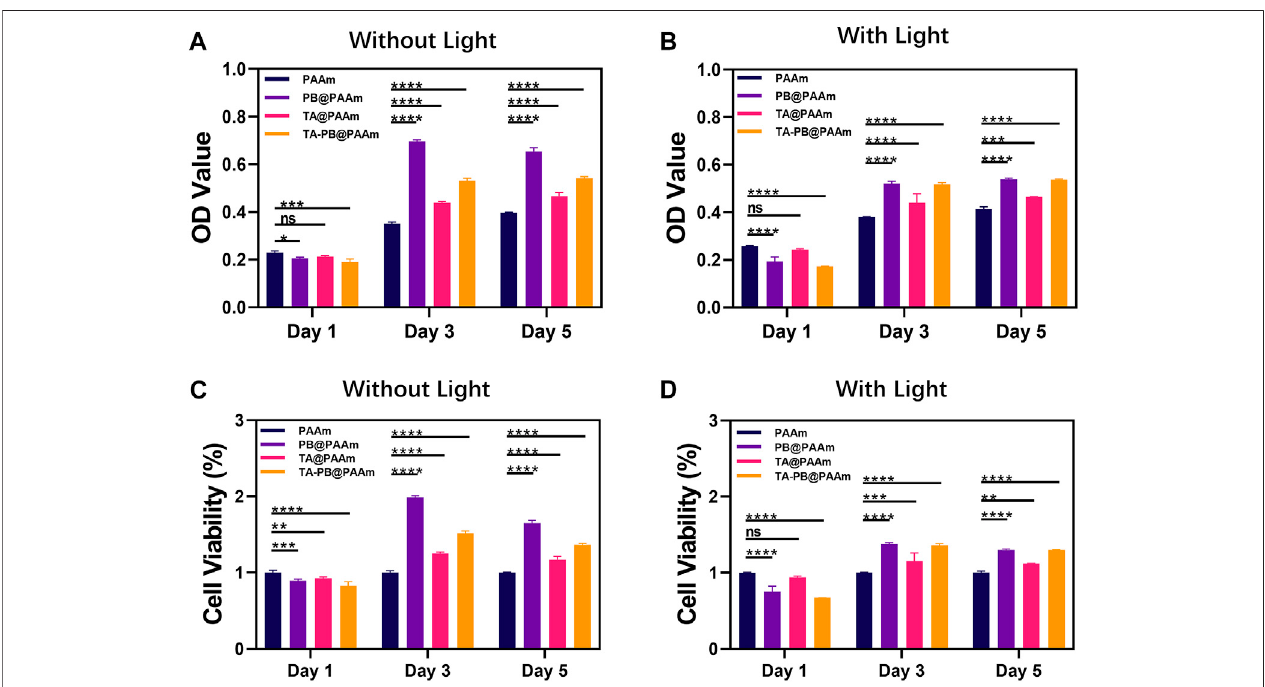
FIGURE 4 | CCK-8 results of NIH-3T3 cells co-cultured with composite photothermal hydrogels at different time points. (A – B) Absorbance in PAAm, PB@PAAm, TA@PAAm, TA-PB@PAAm with or without light. (C – D) Survival rate in PAAm, PB@PAAm, TA@PAAm, TA-PB@PAAm with or without light. Data are mean ± SD (n (cid:1) 3, * p < 0.05, ** p < 0.01, *** p < 0.001, **** p < 0.0001, ns (cid:1) no statistical